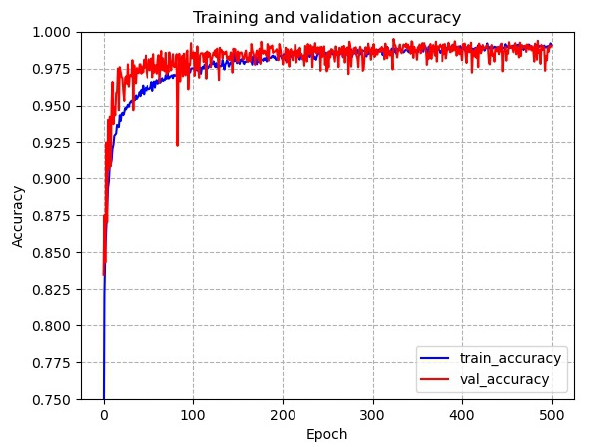
Figure 13. Accuracy of Max-AVG pooling network for tool wear condition diagnosis. (3) Performance comparison of two improved network models.